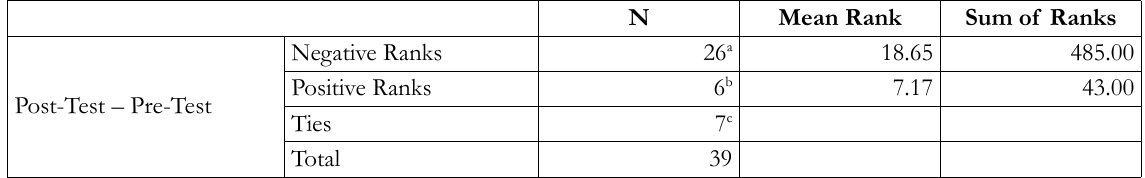
Table 16. Details of ranks of pre- and post-test scores